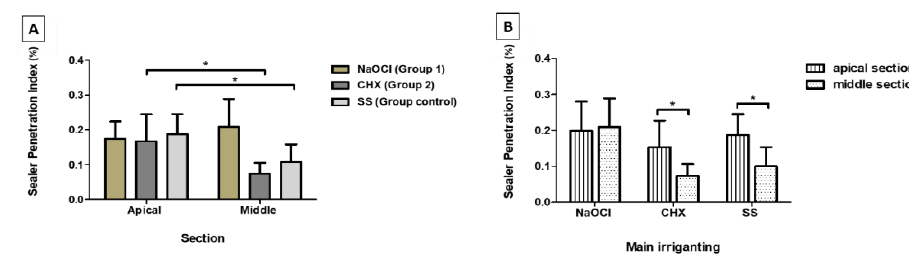
Figure 5. Mean percentage of sealer penetration in the two analyzed sections and in the different final